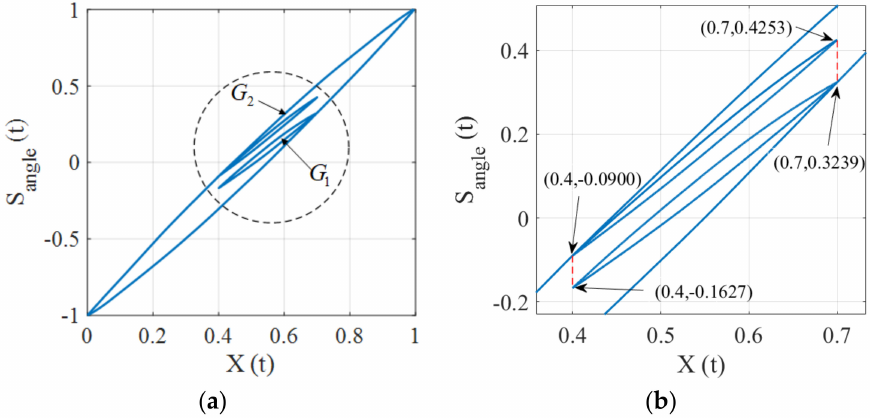
Figure 10. Illustration of the congruency property for the hysteresis model. (a) Hysteresis trajectory. (b) An enlarged view of the circle